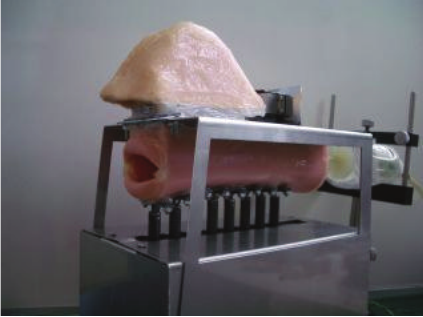
Figure 1: Structural view of talking